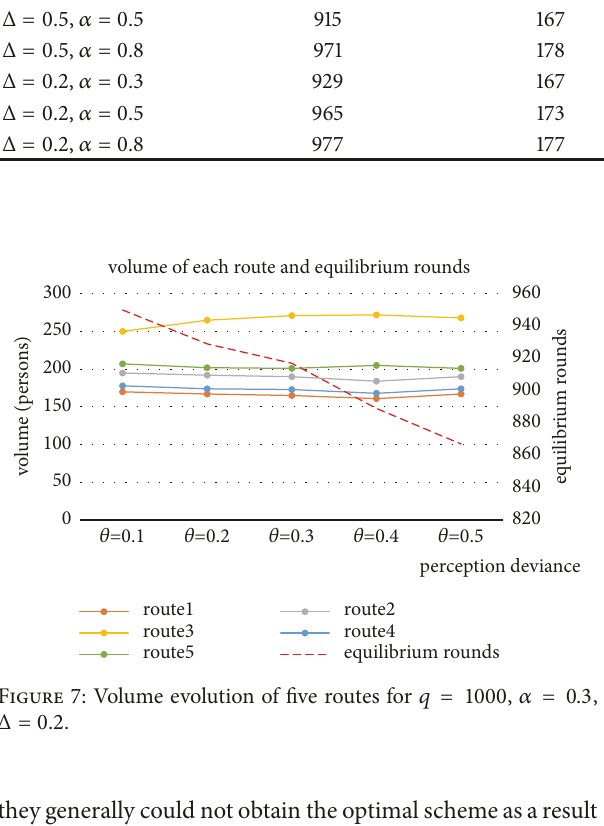
they generally could not obtain the optimal scheme as a result of information limitation and